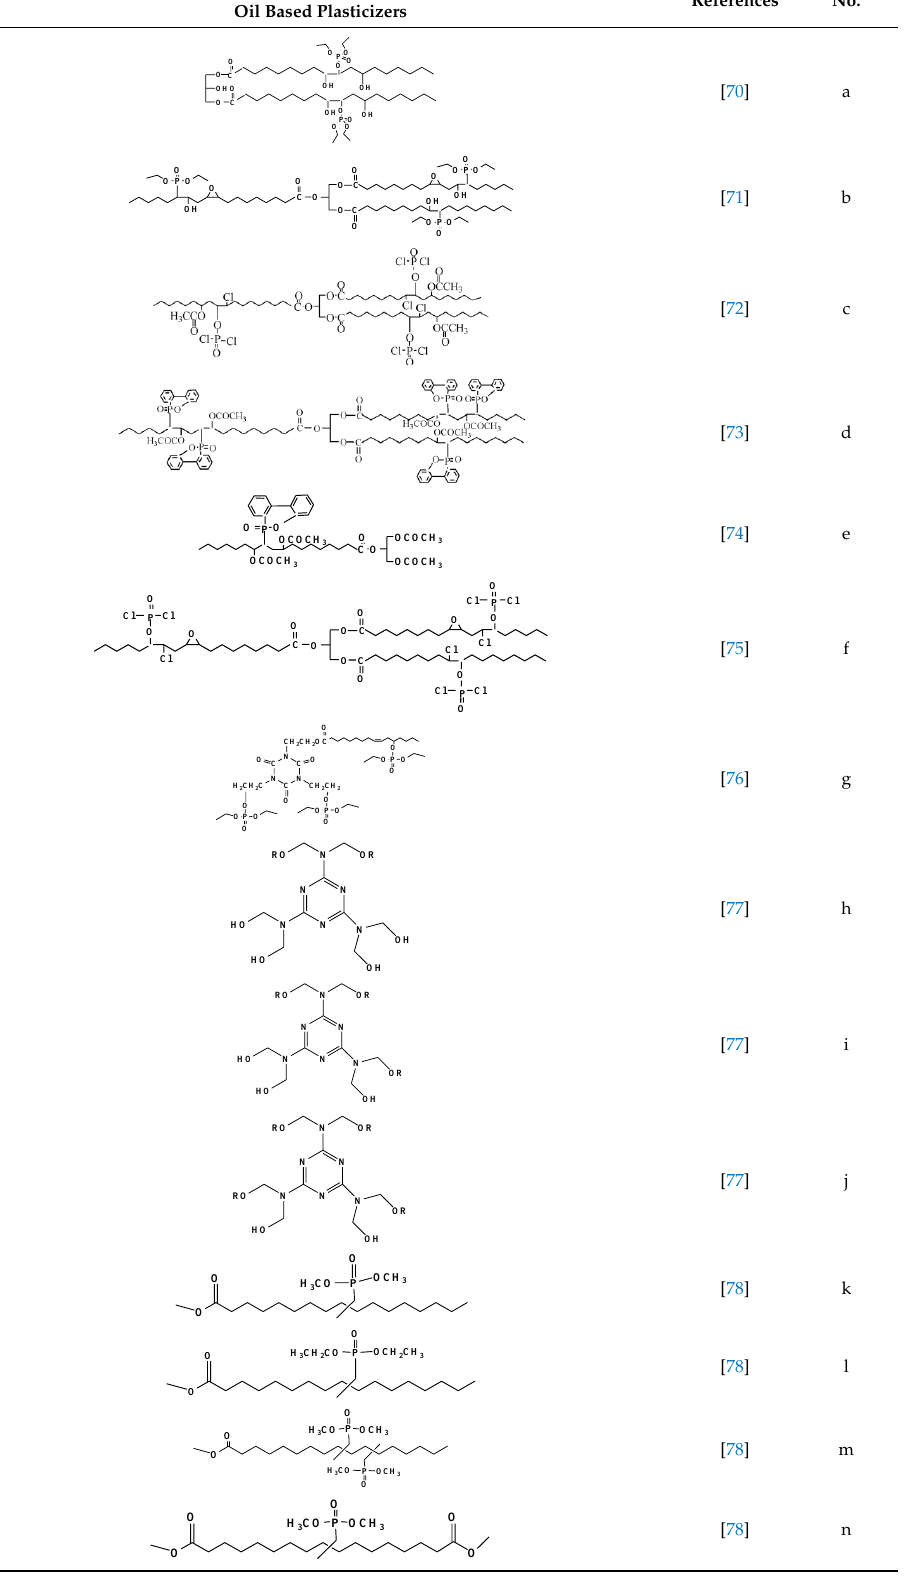
Figure 18. Synthesis of phosphonate groups containing bio-based plasticizers. Table 1. Flame-retardant elements (phosphate, chlorine and nitrogen) containing vegetable oil-based plasticizers.